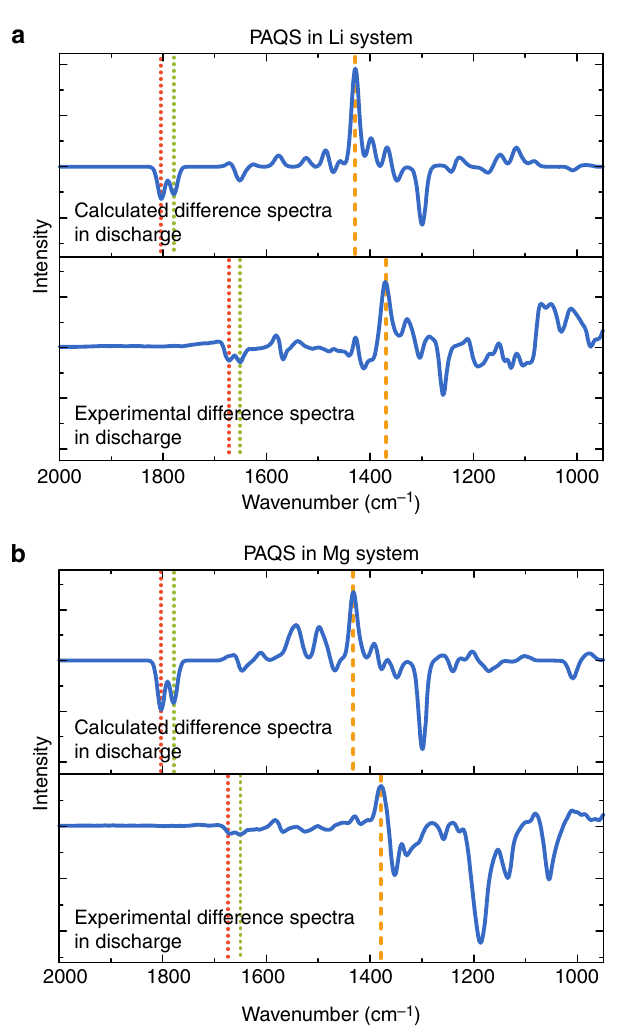
Fig. 5 Comparison of the calculated and experimental difference spectra in discharge with assigned vibrational modes. a Calculated and experimental difference spectra in discharge for PAQS in Li battery system. b Calculated and experimental difference spectra in discharge for PAQS in Mg battery system. Dotted lines represent C = O vibrational modes of PAQS and dashed lines represent C – O – vibrational modes of PAQS 2